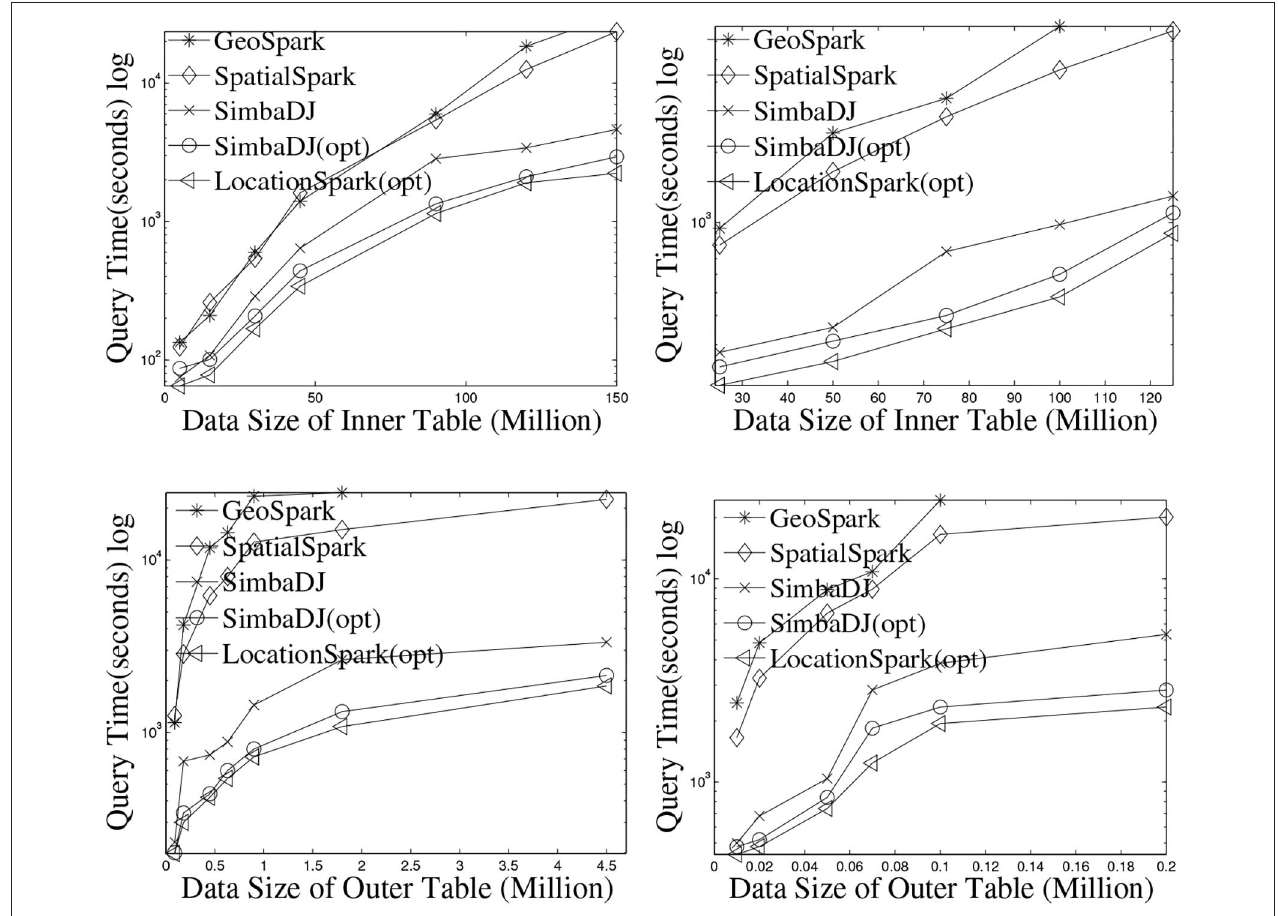
FIGURE 5 | The performance of spatial range join on dataset: Twitter and